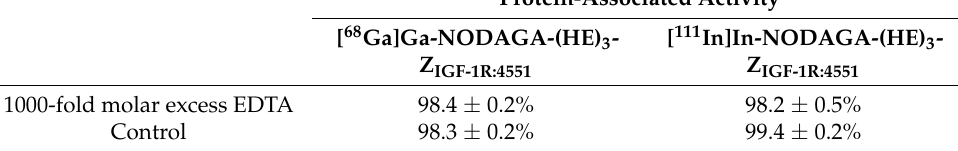
Table 1. Stability of radiolabeled conjugates under challenge with 1000-fold molar excess of EDTA. The challenge time was 1 h for 68 Ga and 6 h for 111 In. The data are presented as an average ( n = 2) ± maximum